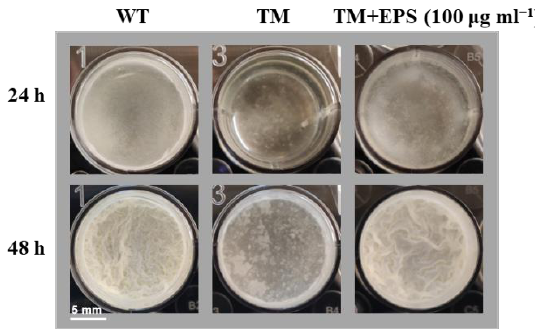
Figure 6. The effect of EPS on TM biofilm formation. The strains of WT and TM were grown in the LBMG liquid medium, supplemented with or without 100 µ g mL − 1 EPS, and observed for biofilm formation. The scale represents 5 mm.